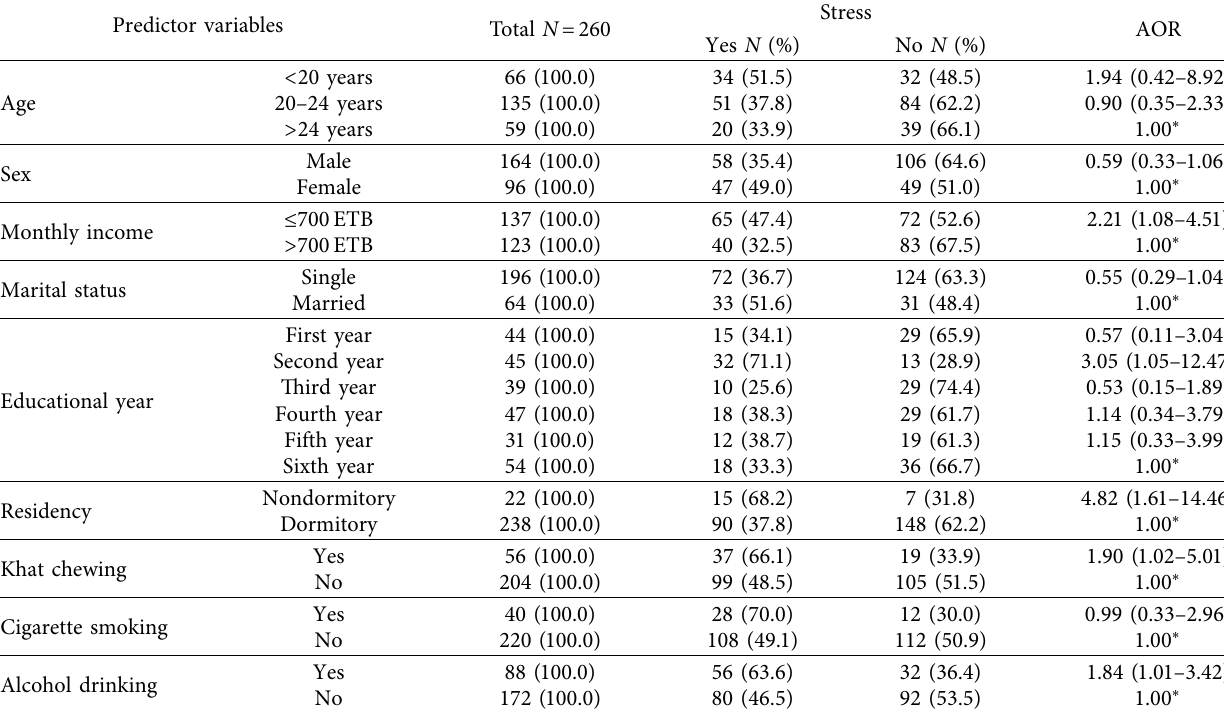
Table 10: Multiple logistic regressions of stress and predictor variables, N � 260, AU, January